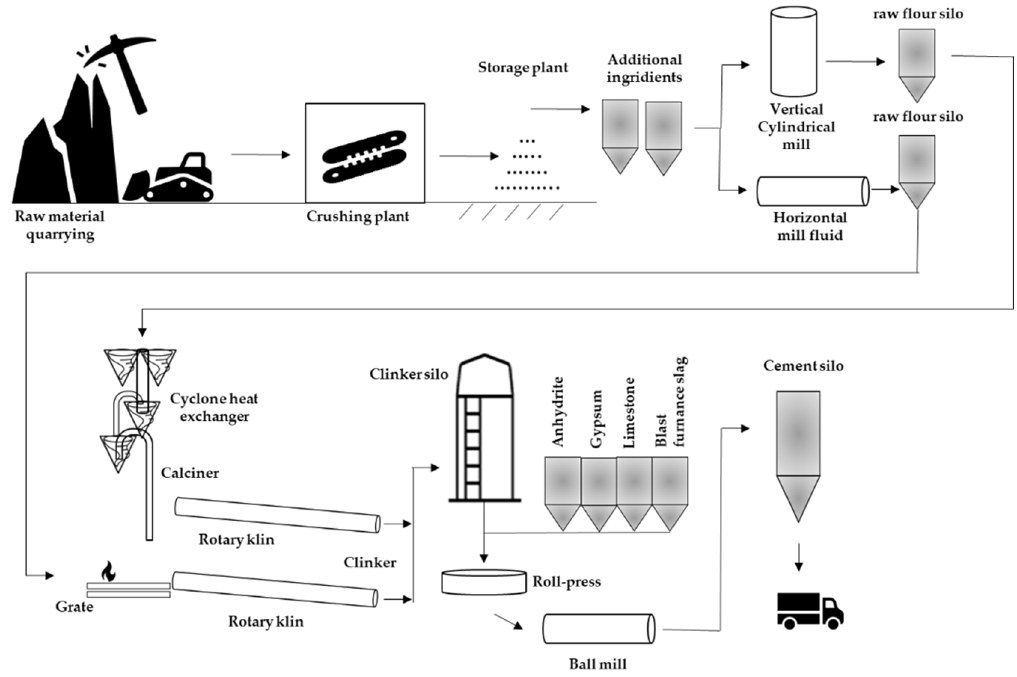
Figure 6. Portland clinker and cement production.